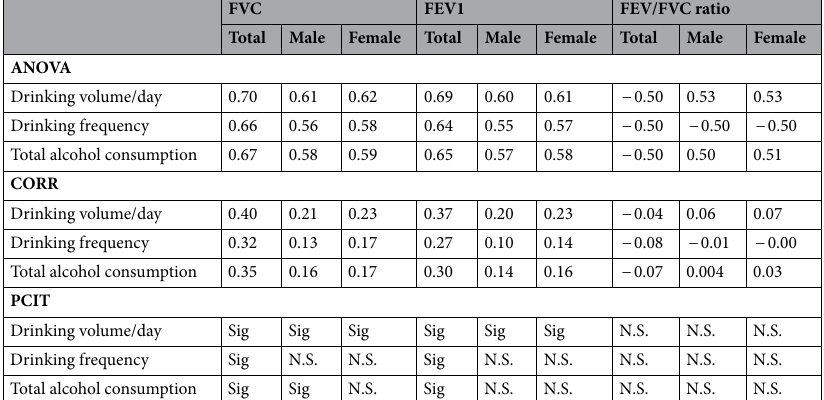
FVC FEV1 FEV/FVC